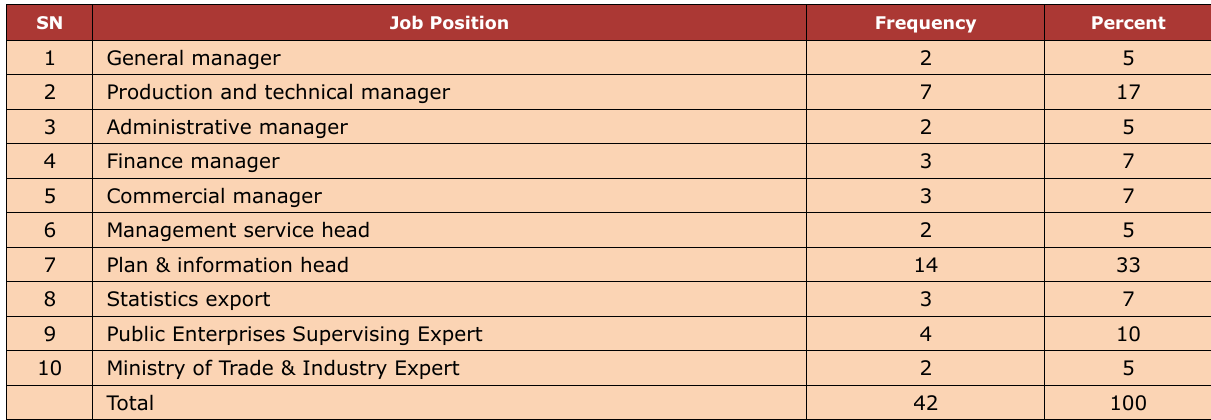
Table 3. Respondents’ job